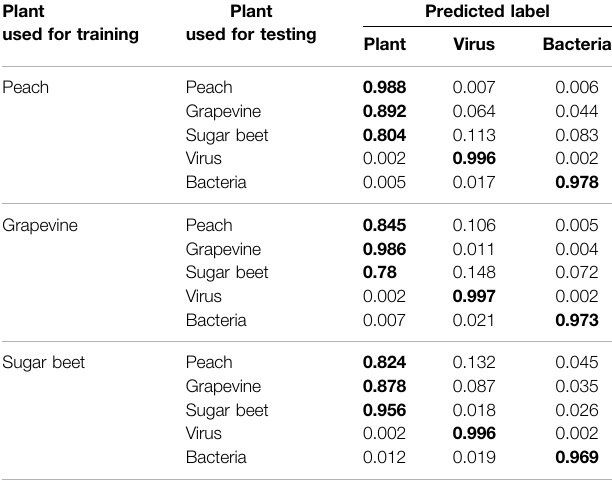
TABLE 1 | VirHunter results for prediction of fragments from different plants. Classi fi cation results for three plant-speci fi c models of 10 , 000 fragments for length 1000 randomly drawn from three plants ’ reference genomes, from all viral sequences andbacteriaareshown.Inboldarepredictions fortheexpectedclass. Plant used for